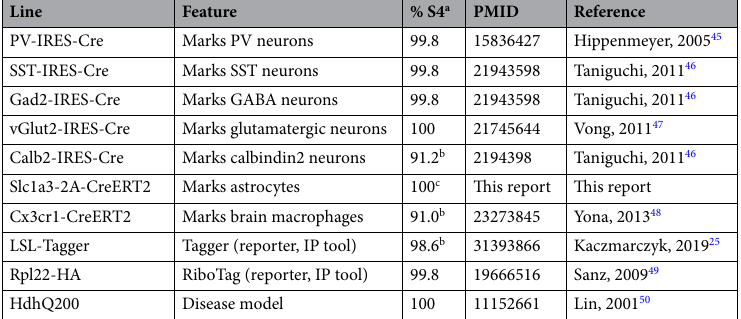
Table 1. Knock-in mouse lines backcrossed to S4. PV parvalbumin, SST somatostatin, GABA gamma- aminobutyric acid, IP immunoprecipitation. a Based on genotyping 347 loci across the genome that discriminate S4 from B6. b These lines were backcrossed four more generations after genotyping analysis. c This line was made directly in